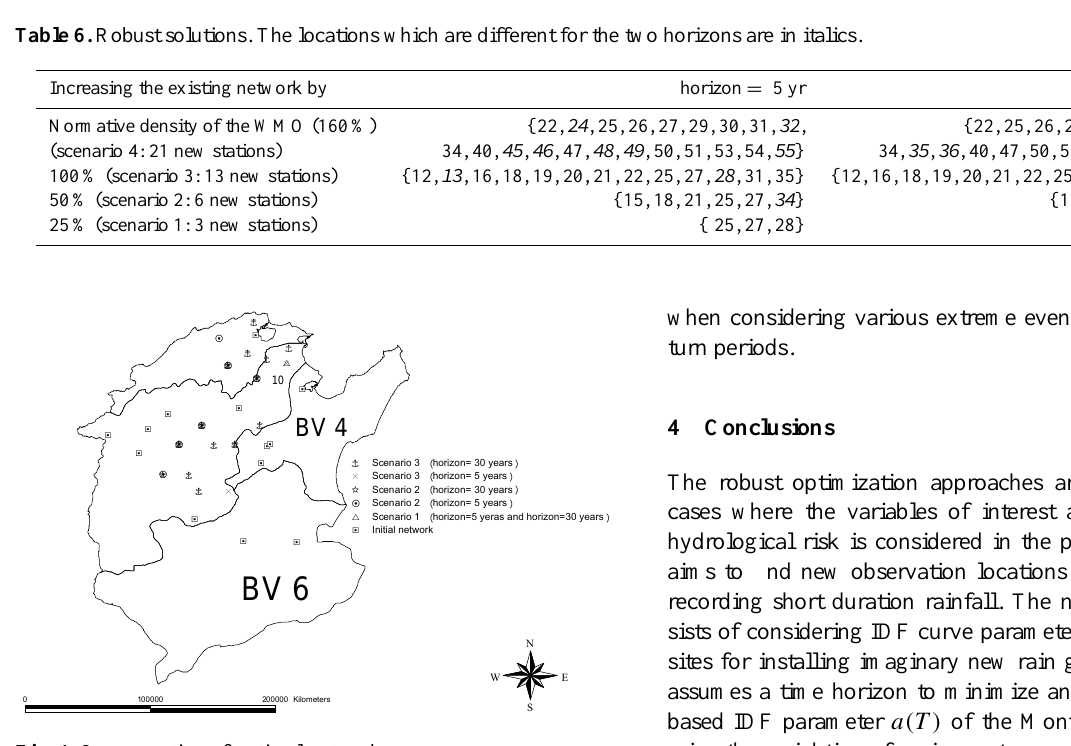
Fig. 4. Configuration of optimal Figure 4. Configuration of optimal networks